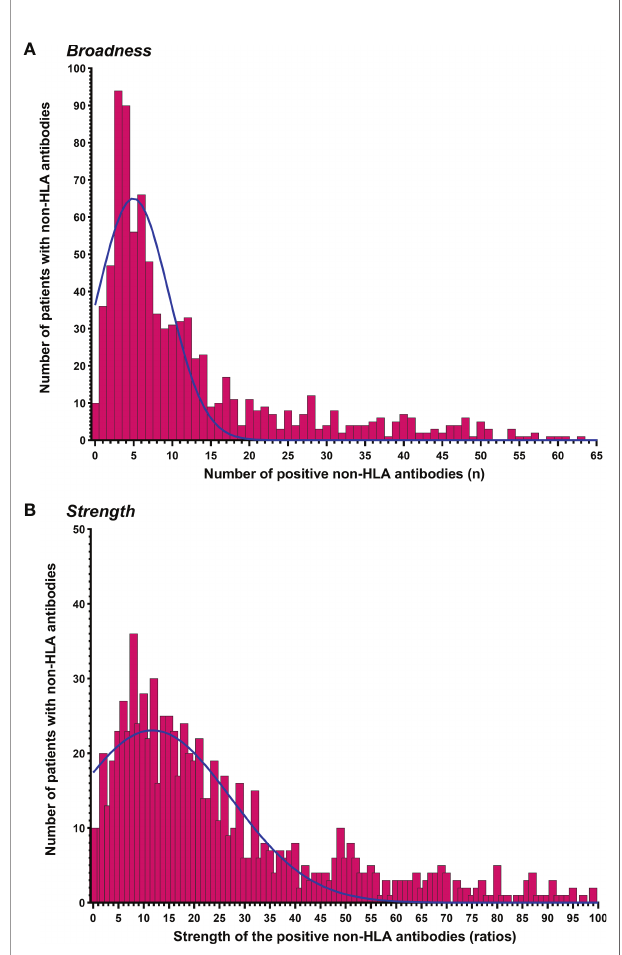
FIGURE 2 | Distribution of patients by the number of positive pretransplant non-HLA antibodies. (A) The broadness of non-HLA antibody pro fi le (number of positive non-HLA antibodies per patient). (B) The strength of non-HLA antibody pro fi le (total ratios of the positive non-HLA antibodies per patient). 46 patients with ratios between 101 and 224 were not plotted on the